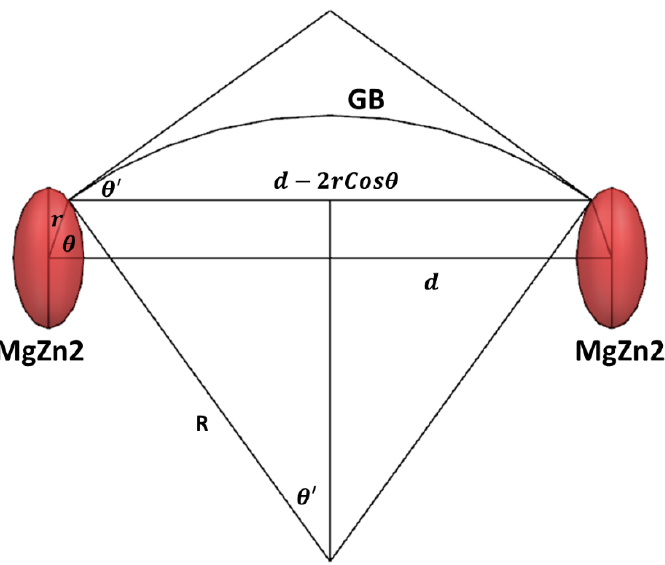
Figure 11. Dragging of the grain boundary migration by two MgZn 2 particles.